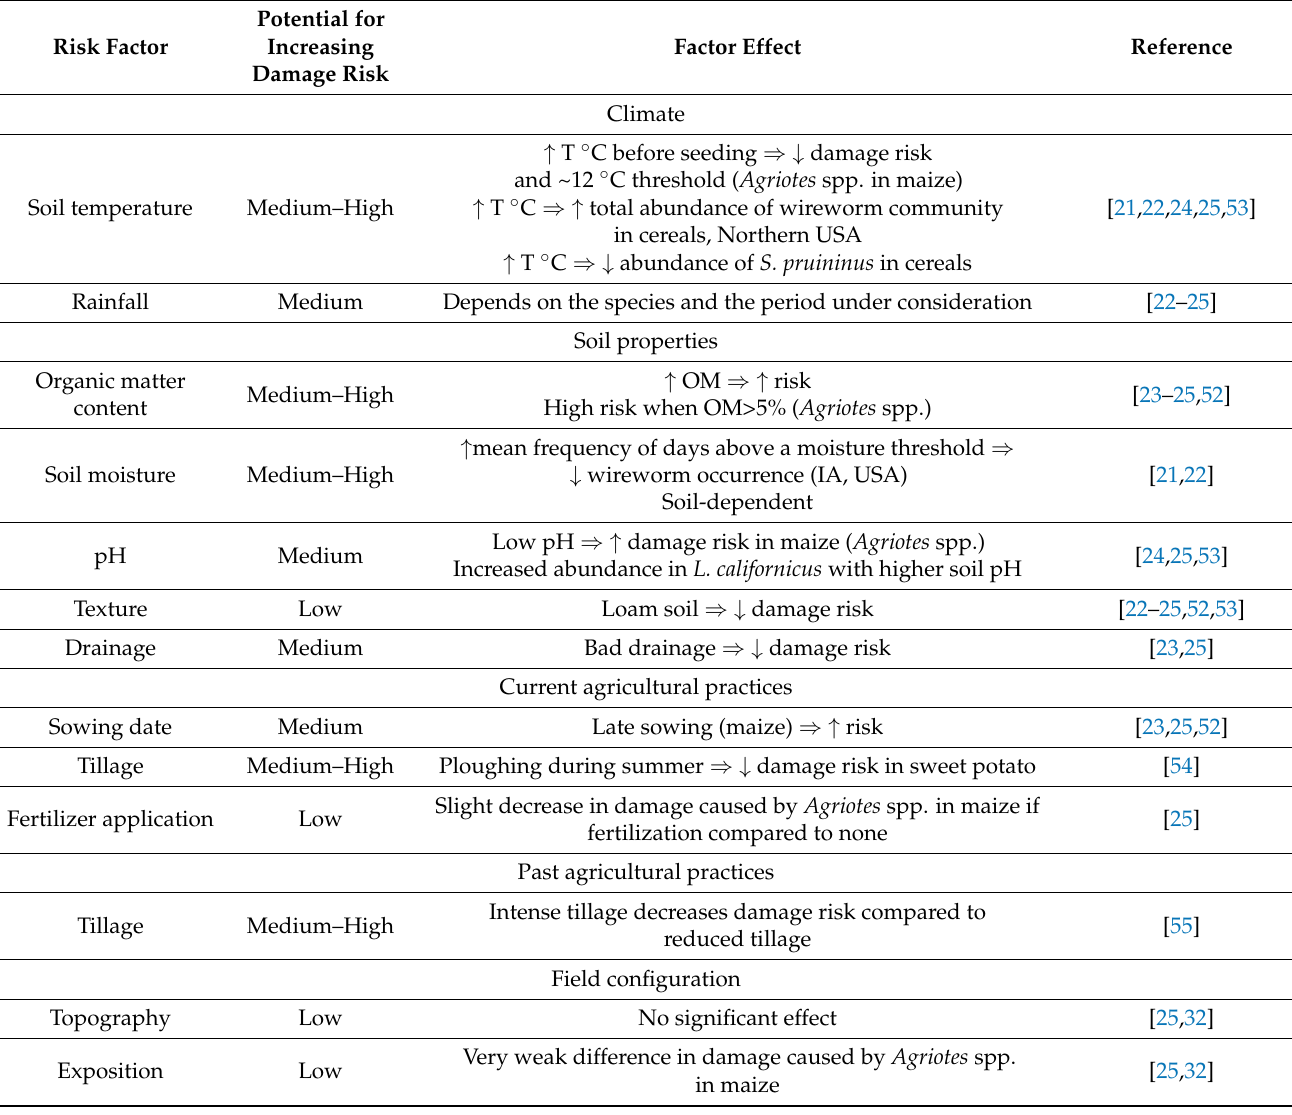
Table 1. List of risk factors driving wireworm infestation and resulting in crop damage. Cited references provide examples of studies evaluating the risk factor, without any claim for exhaustiveness. A considerable effort would be required to achieve an overview of all situations in terms of species × crop ×